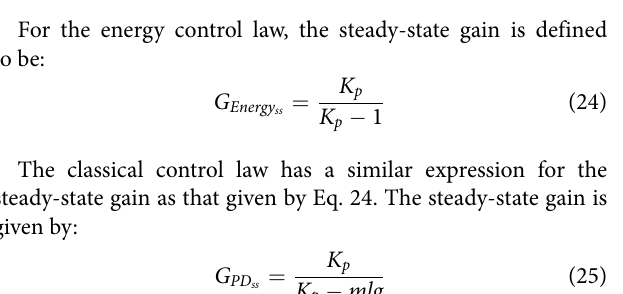
FIGURE 8 | Angular stability regions as defined by the SIP Ankle Balance Strategy